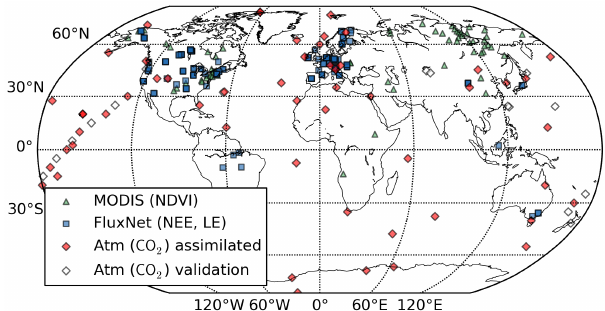
Figure 3. Location of the different observations used for each data stream assimilated in the system: MODIS-NDVI measurements, FLUXNET sites with NEE and LE measurements and atmospheric CO 2 stations (both the sites that are assimilated and the sites used for the